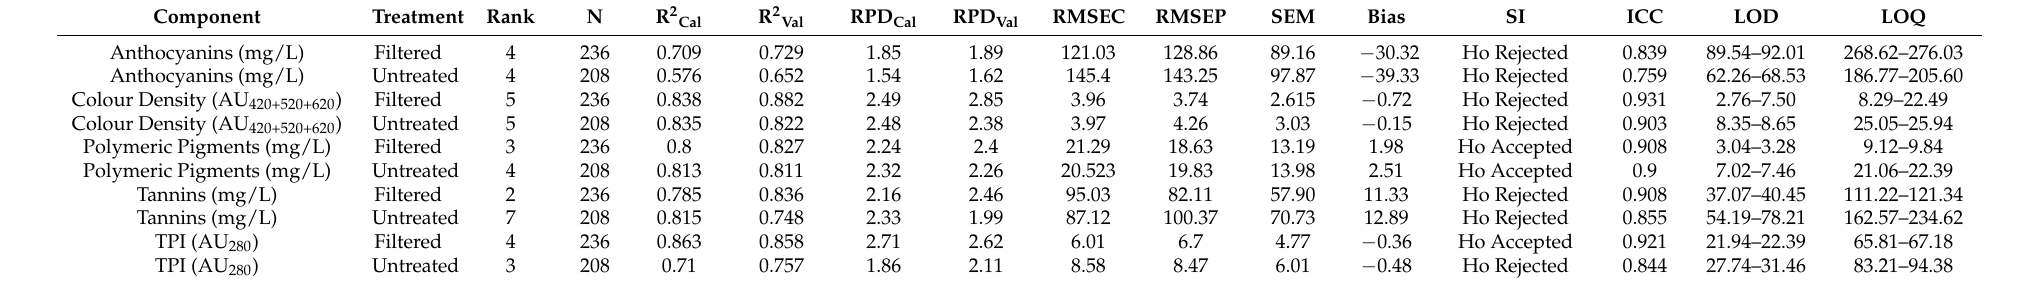
Table 3. Summary statistics for filtered and untreated samples using transmission Fourier-transform near-infrared (T-FT-NIR) spectroscopy. Component Anthocyanins